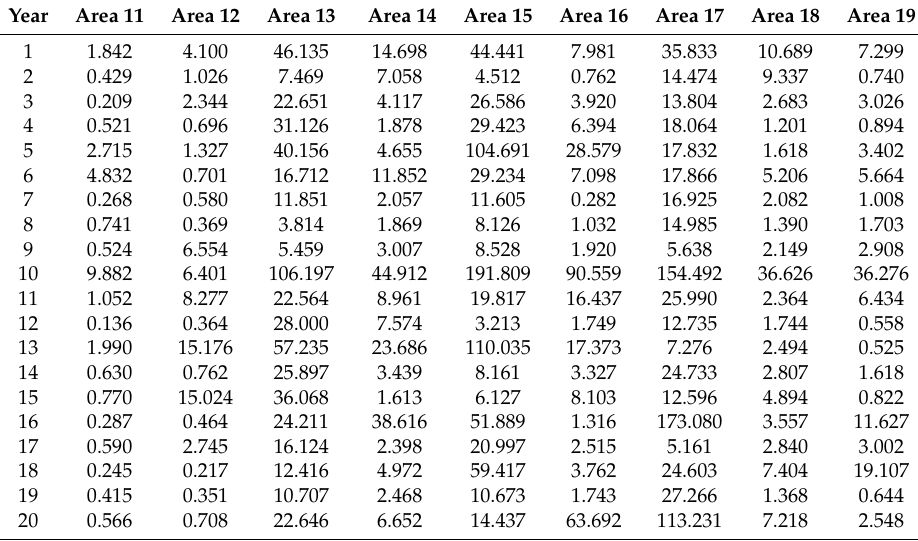
Table 12. Insurance losses in Example 5, part